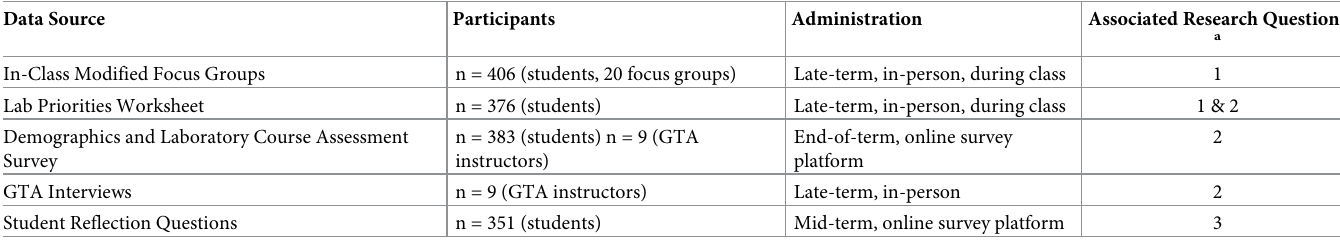
Table 1. Data collection